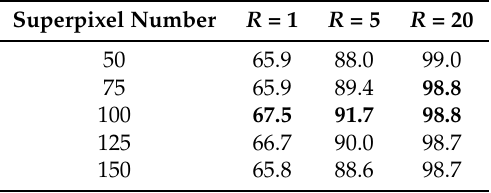
Table 4. Evaluation of the number of superpixel on iLIDS-VID. Bold values indicate the best